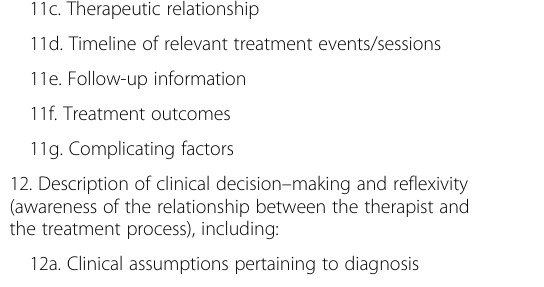
Table 11 Case Study Evaluation-tool (CaSE) checklist for essential components in systematic case studies. Recommended